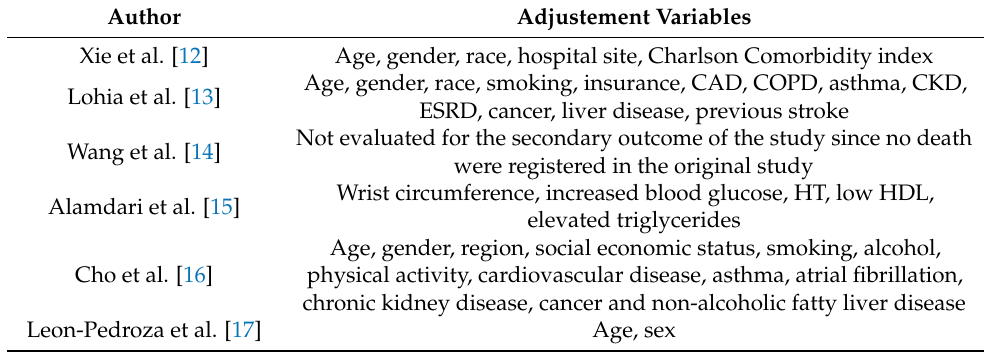
Table 4. Variables used in the revised studies to calculate the adjusted odd ratio for the mortality risk in COVID-19 patients with metabolic syndrome. CAD: Coronary artery disease; COPD: Chronic obstructive pulmonary disease; CKD: Chronic kidney disease; ESRD: End-stage renal disease; HT: Arterial hypertension; HDL: High-density lipoprotein.